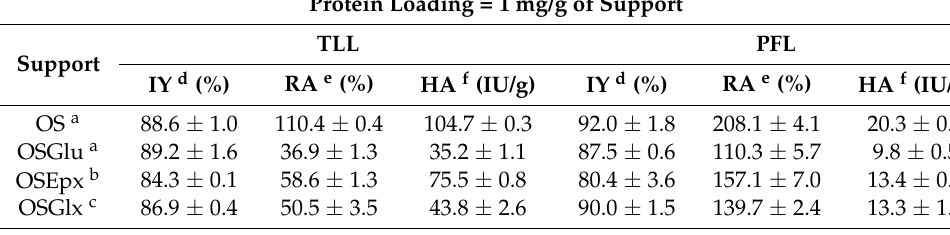
Table 1. Catalytic properties of the biocatalysts prepared by immobilization of PFL and TLL on mono and heterofunctional silica